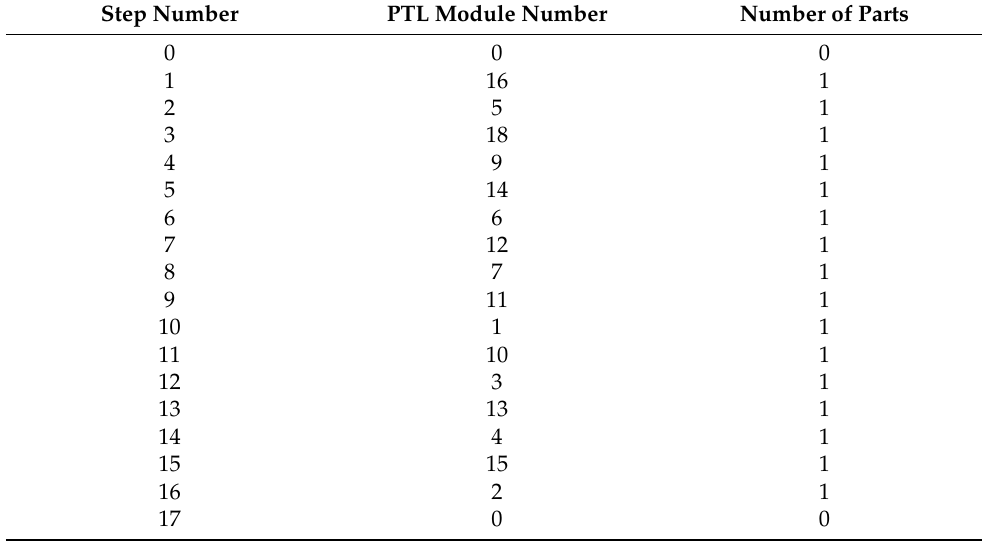
Table 3. The content of Instructions.xlsx document for assembly of Gillux-Puzzle (solution field 18).